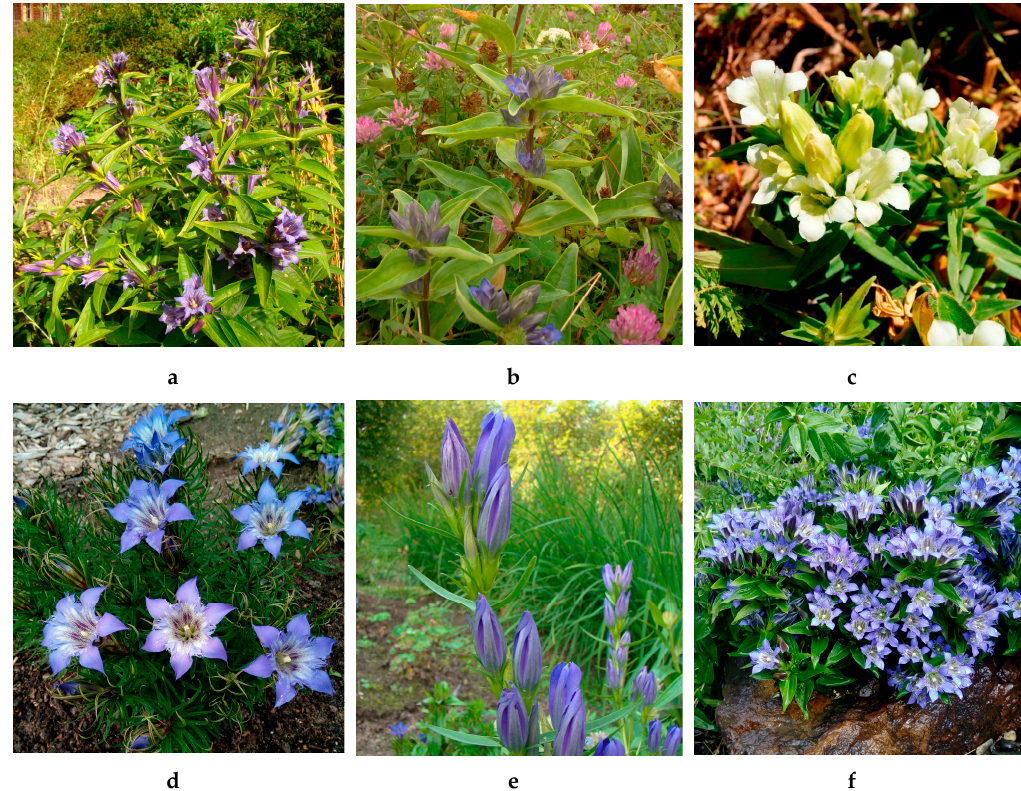
Figure 1. Caucasian gentians studied in present work: Gentiana asclepiadea ( a ), G. cruciata ( b ), G. gelida ( c ), G. paradoxa ( d ), G. pneumonanthe ( e ), G. septemfida ( f ).